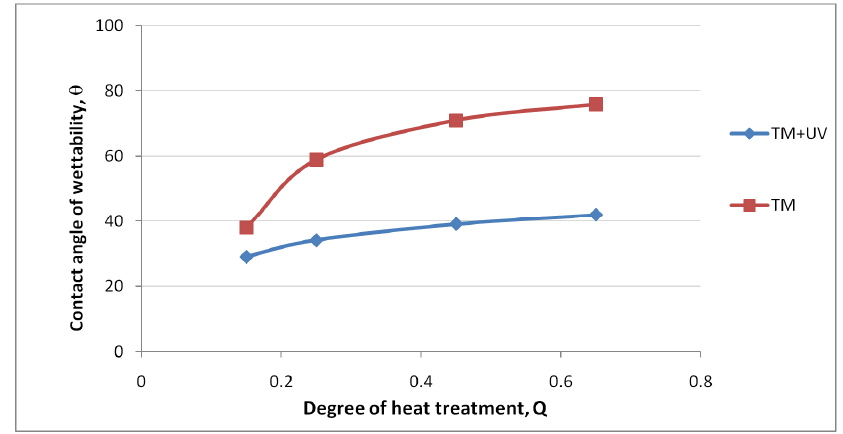
Figure 8. Influence of the degree of heat treatment on the contact angle of wood wetting.